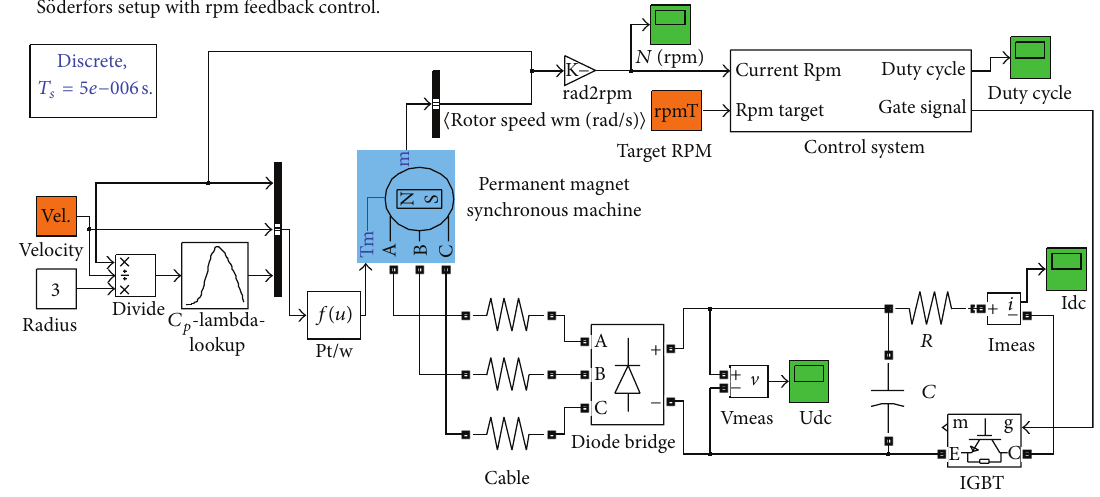
Figure 4: Simulink model of the S¨oderfors turbine and generator with control of rotational speed.